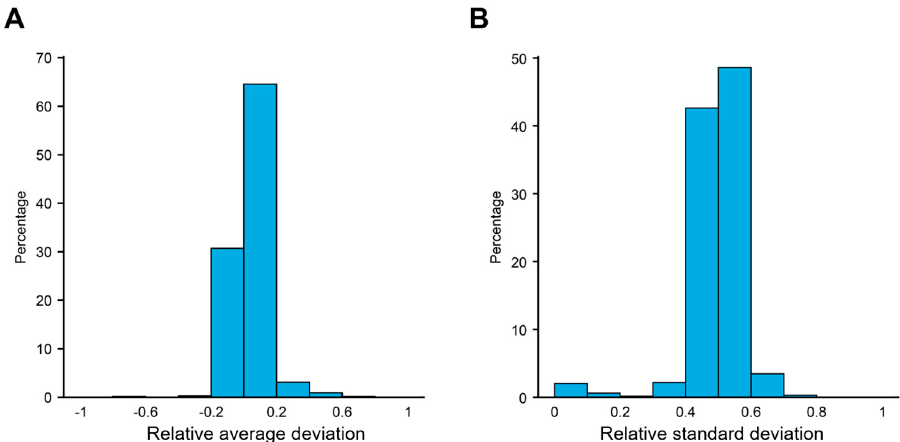
Figure 7. Relative average deviation and relative standard deviation distribution histogram of the excess phase Doppler of the reconstructed B ∗ , ( A ) is relative average deviation and ( B ) is relative standard deviation.